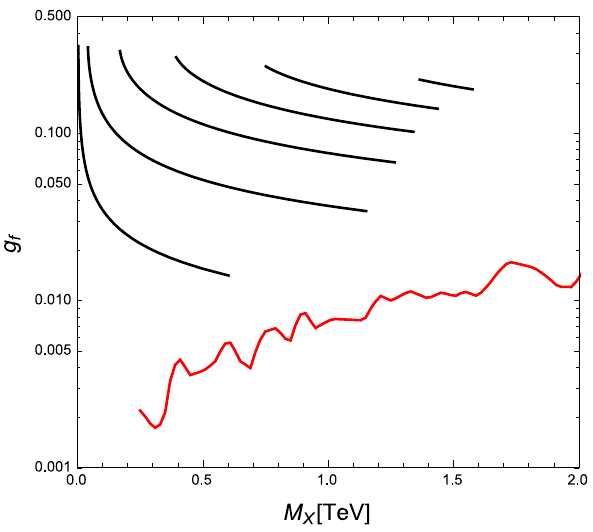
Figure 6 . The plot of M X versus g f for the annihilation process (ii) ¯ ζ ‘ ζ ‘ → X X . The black solid curves from left to right depict the results for a = 0 . 3 , 1 , 2 , 3 , 4 and 5 , respectively, from left to right, along which Ω DM h 2 = 0 . 12 is satisfied. The diagonal red line shows the upper bound on g f as a function of M X ≥ 0 . 25 TeV from the LHC Run-2 results. No allowed region exists for M X ≥ 0 . 25 TeV, which can simultaneously satisfy the cosmological and LHC